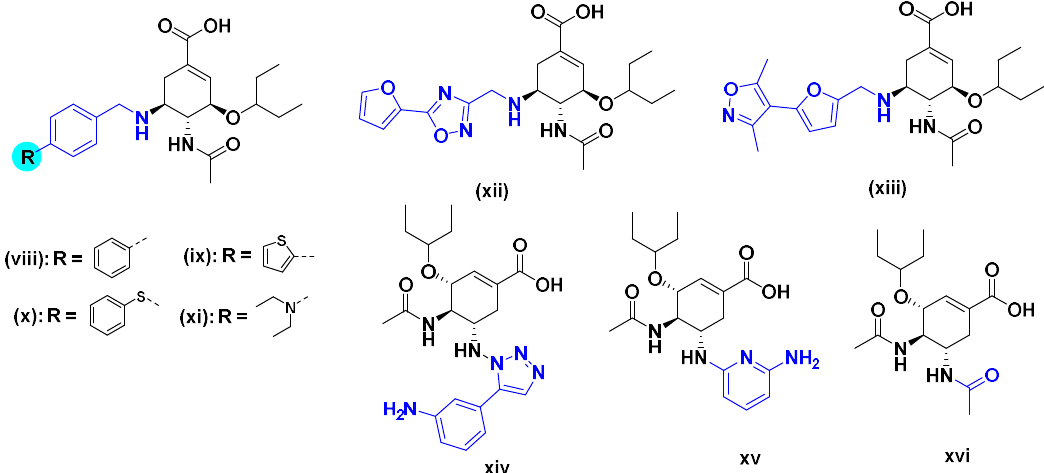
Figure 2. Representative C-5-NH 2 modified OC derivatives designed as 150-cavity binders: secondary amine derivatives ( viii – xiii ), triazolylated analogue ( xiv ), pyridyl analogue ( xv ) and acyl analogue ( xvi ).